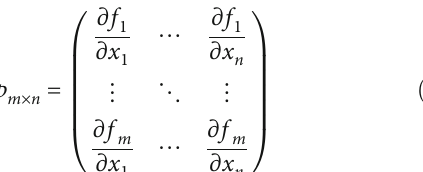
Figure 1: Physical model of the vertical